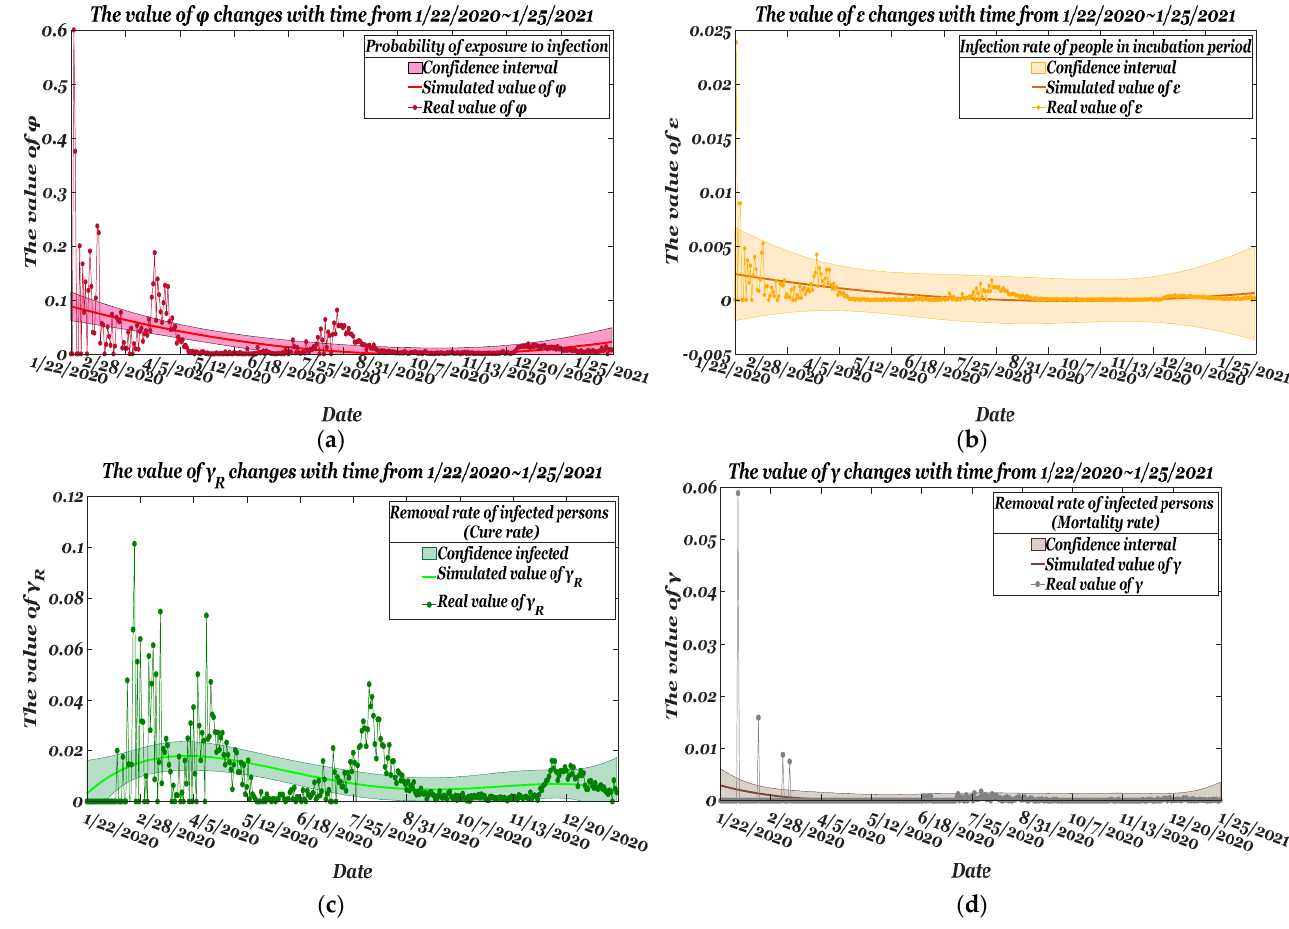
Figure 2. Comparison of real parameters and the varying rate of estimated parameters from 22 Jan-